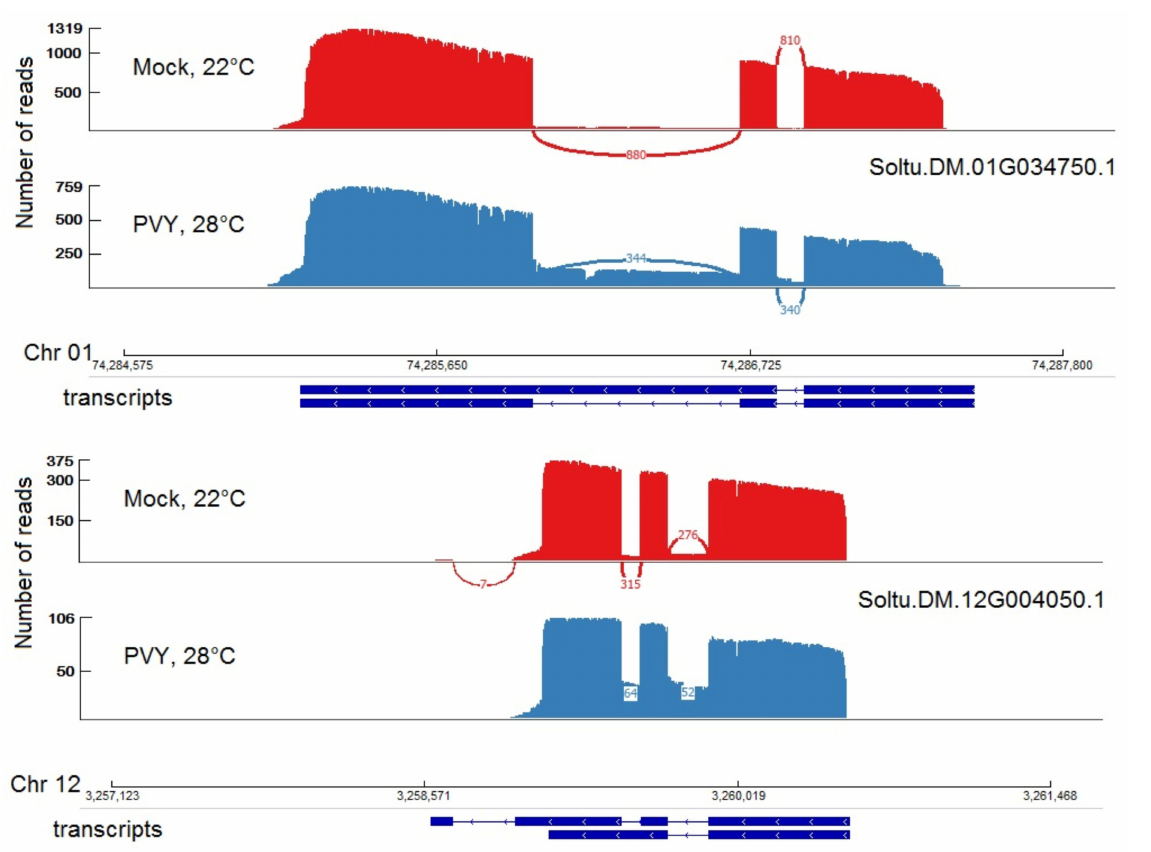
Figure 8. Sashimi plots of Nanopore data demonstrating examples of two WRKY transcription factors with upregulation of isoform with intron retention in plants under combined (PVY + heat) stress. The main panel shows counts of the reads that span the junctions. The transcripts correspond to chr01:74285180..74287496 and chr12:3259116..3260538 according to chromosome (chr) positions of Phytozome database Solanum tuberosum genome